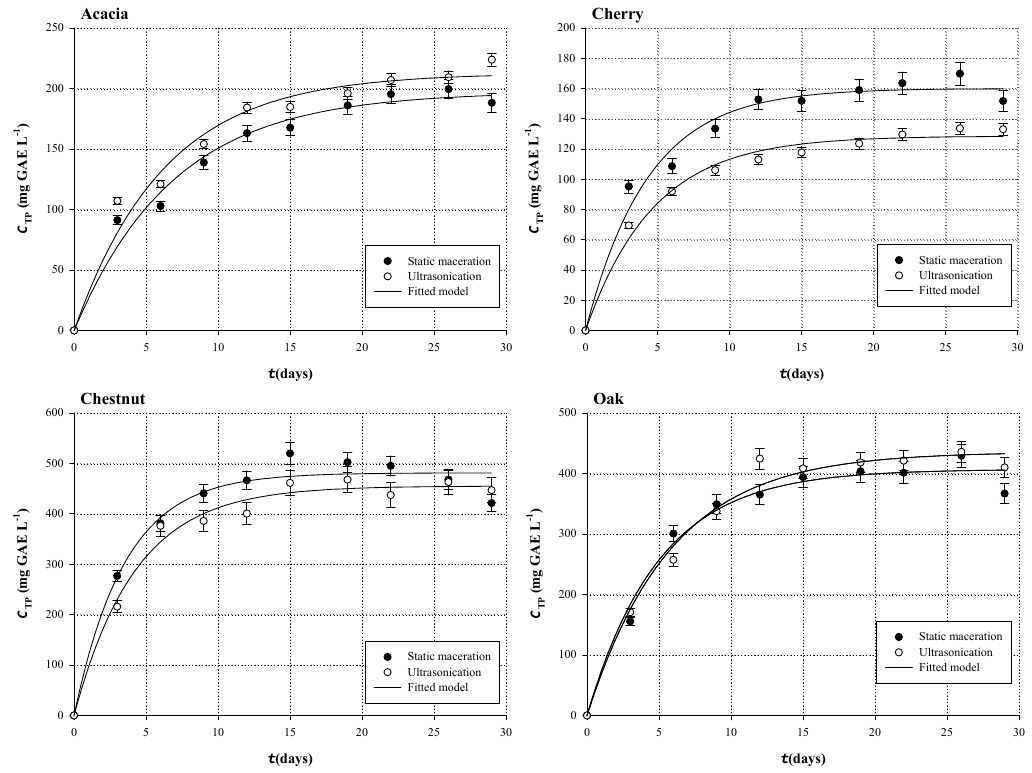
Figure 1. Time course of polyphenol release from wooden chips into Tsipouro, under SM (static maceration) and US (ultrasonication). Treatments were carried out over a period of 30 days. Table 1. Kinetic parameters estimated for accelerating aging of Tsipouro using wooden chips from various botanical species, under SM (static maceration) and US (ultrasonication). Treatments were carried out over a period of 30